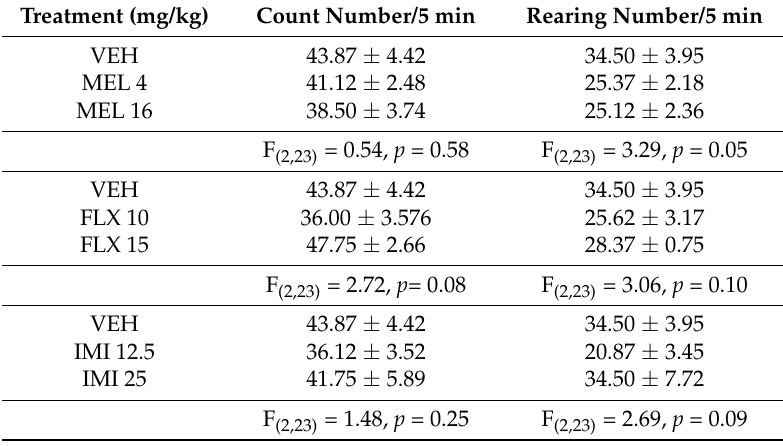
Table 1. Mice ambulatory activity assessed through the Open Field Test